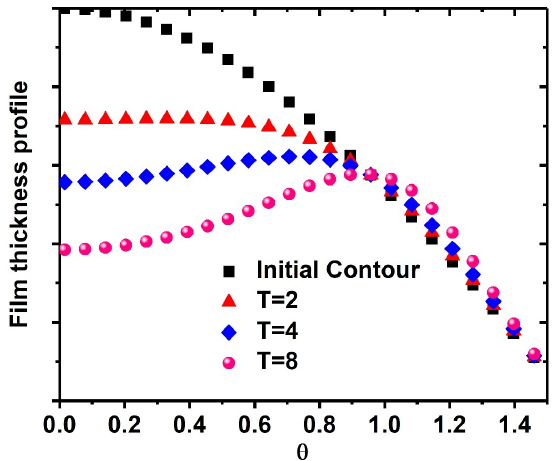
Figure 9. Film thickness profile at different T with non ‐ uniform initial film ( h = h 0cos θ ).